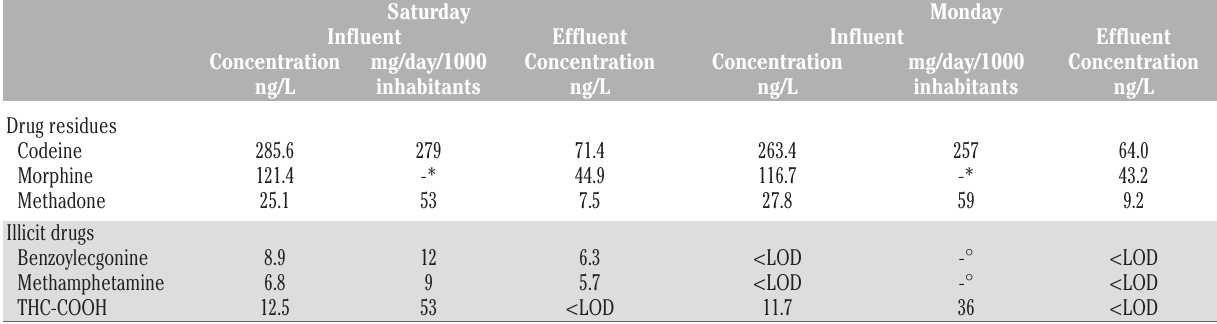
Table 1. Concentrations of illicit drugs and drugs residues in influents and effluents and consumption by community.